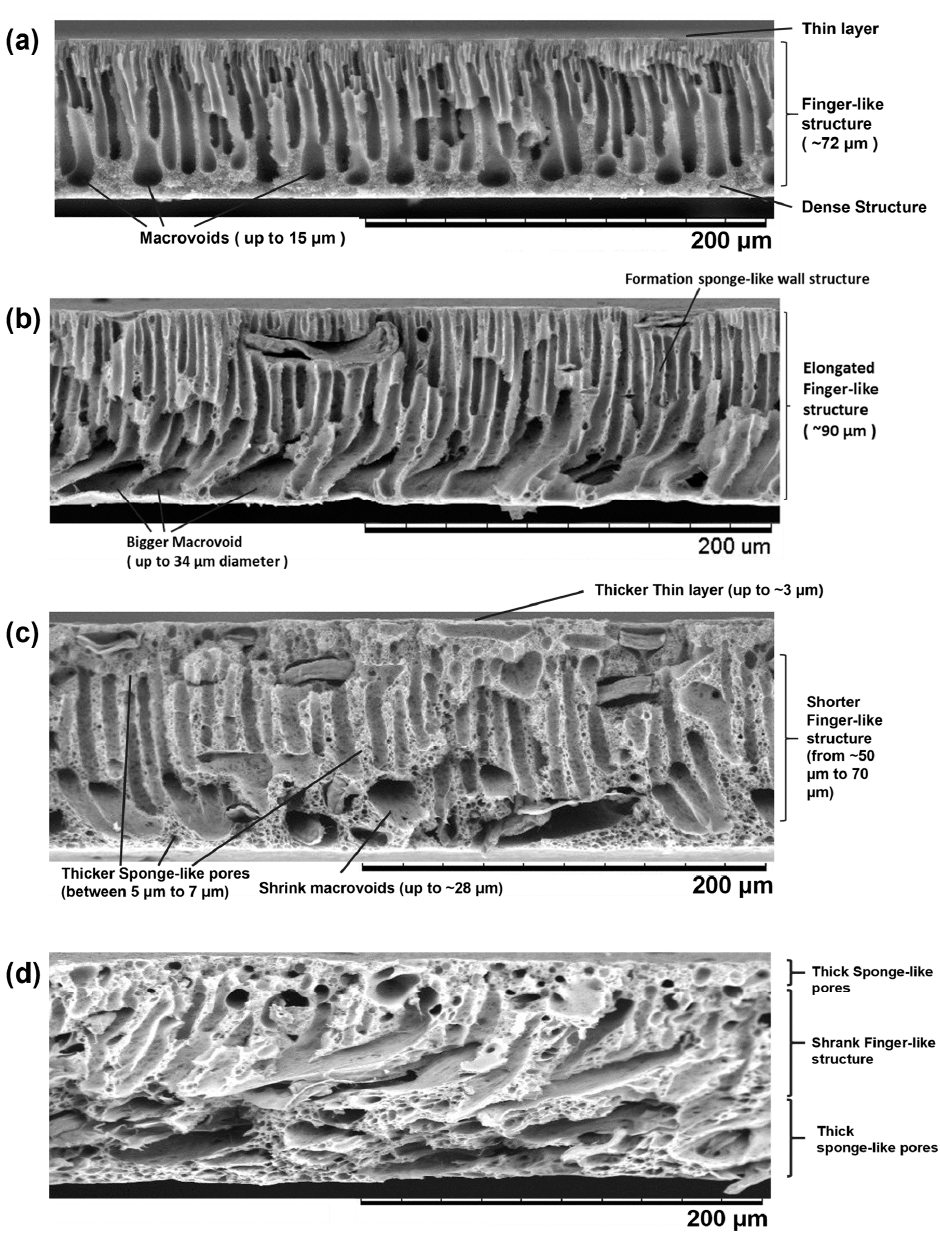
Figure 6. SEM for cross-sectional images of ( a ) pristine PES and MCC-incorporated PES membranes with ( b ) 1 wt.% MCC, ( c ) 3 wt.% MCC, and ( d ) 5 wt.% MCC at 500 ×